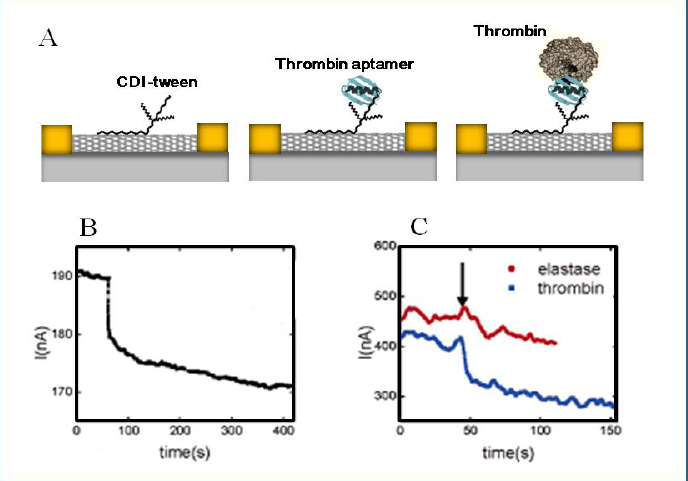
Figure 15. (A) Binding of thrombin on a SWCNT-FET-based aptamer sensor (B) A real- time conductance measurement obtained from the thrombin aptamer immobilized SWCNT-FET. (C) The selectivity of thrombin aptamer immobilized SWCNT-FET. Arrow indicates the point of adding protein solution. Reproduced with permission of ACS